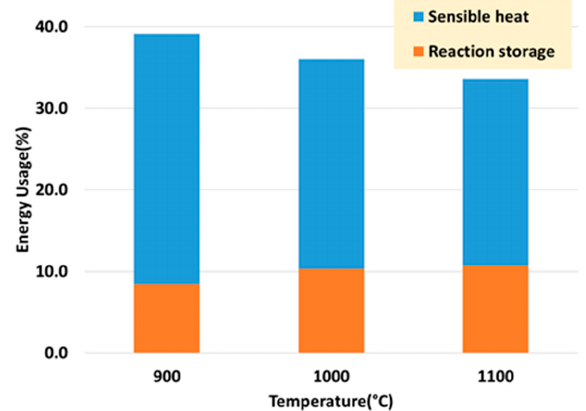
Figure 11. Energy efficiency at molar ratio CO 2 :CH 4 = 1:1 and MRT = 0.0280 s.